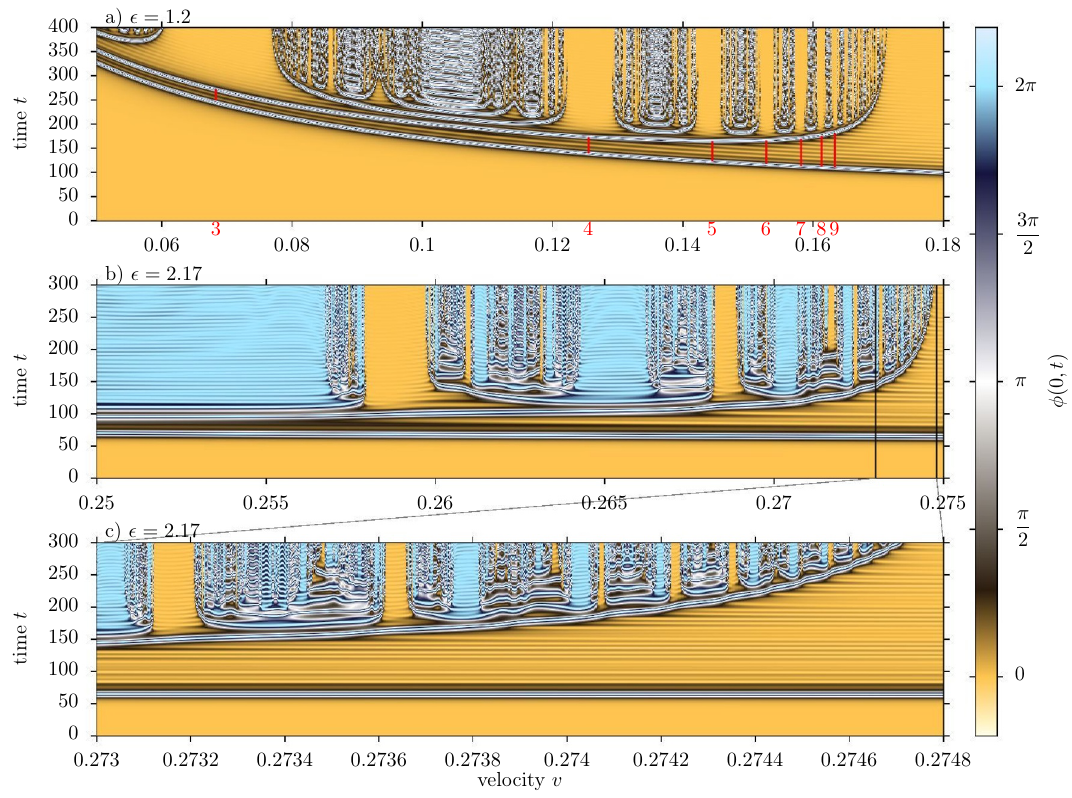
Figure 17 . Field at the centre for (cid:15) = 1 . 2 (a) and (cid:15) = 2 . 17 (b), (c). Subplot (a) shows a regular structure of φ 4 -like windows labelled by the oscillation number n of the first internal mode, as seen for (cid:15) ≤ 1 in figure 14. Subplots (b) and (c) are taken for a value of (cid:15) for which the window structure is much more chaotic. The pattern includes a number of the blue ‘pseudowindows’ discussed more in the main